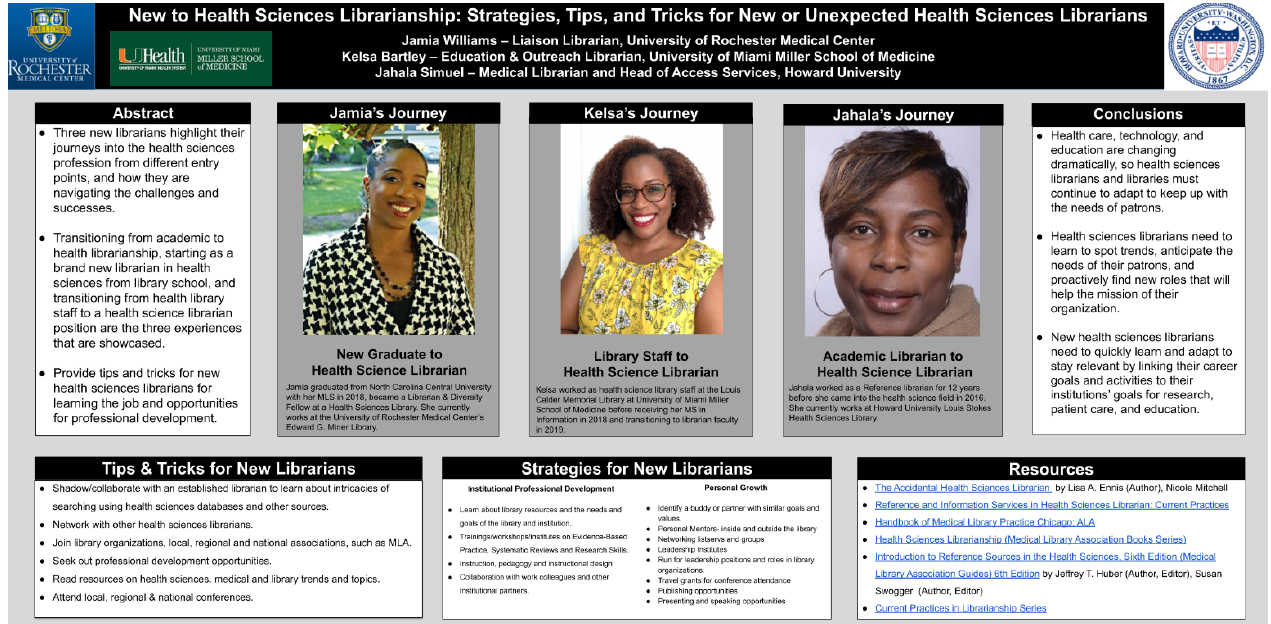
Figure 1 Authors’ poster presented at the 2020 vConference of the Medical Library